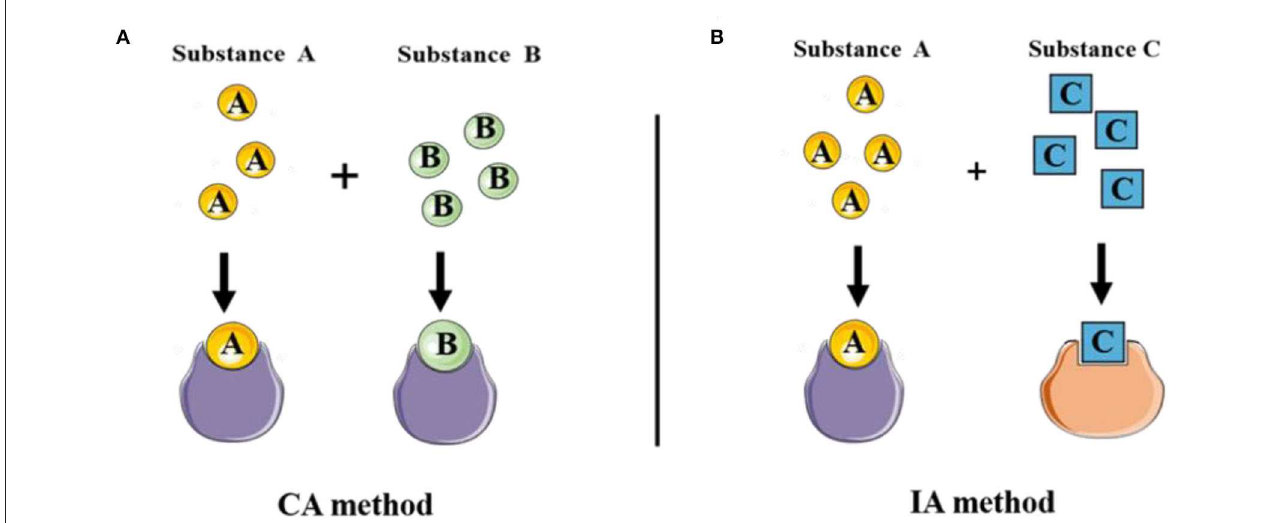
FIGURE 6 | The diverse toxic mode of actions of classical joint prediction model of Concentration addition and Independent Action. (A) CA method was used to evaluate the joint toxicity of chemical substances with the same mechanism of action. (B) IA method was applied to evaluate the combined toxicity of multi-component with the different mechanisms of